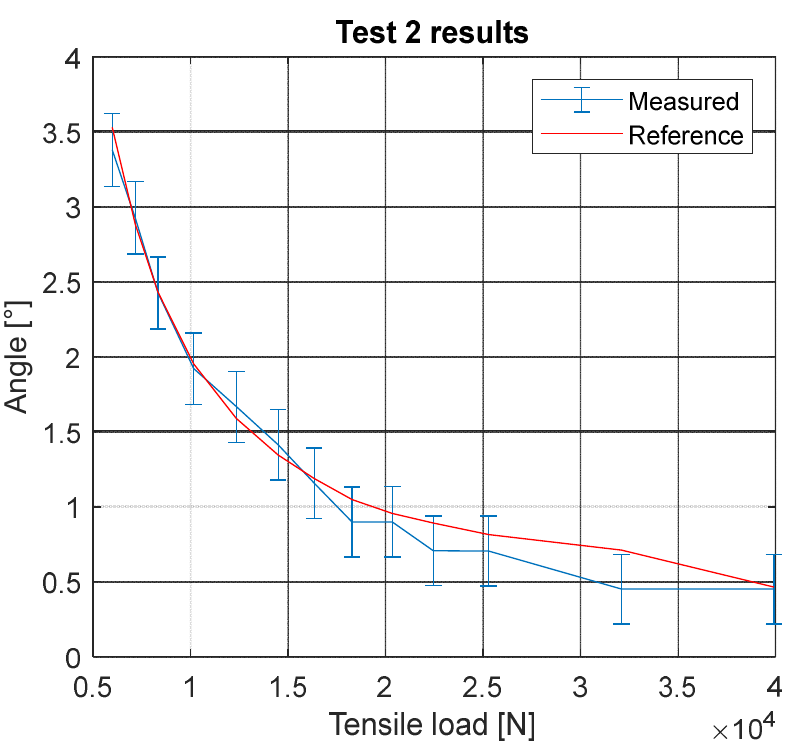
Figure 9. Comparison between the angle value measured by the sensors and the reference one computed through catenary equation in correspondence of the sensor position during Test 2. Error bars represent the uncertainty of the sensor measurements.